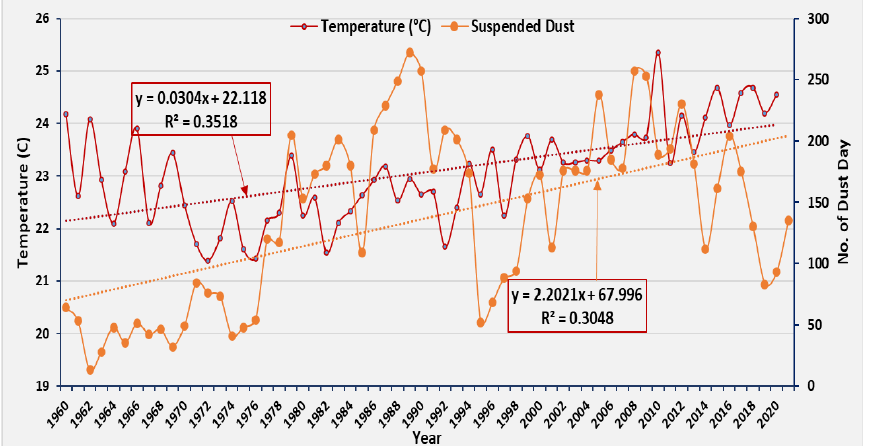
and they are mostly emitted from oil, flaring, gas, cement, and coal for 93 years from 1927 to 2020, according to the analysis (Figure 4c).